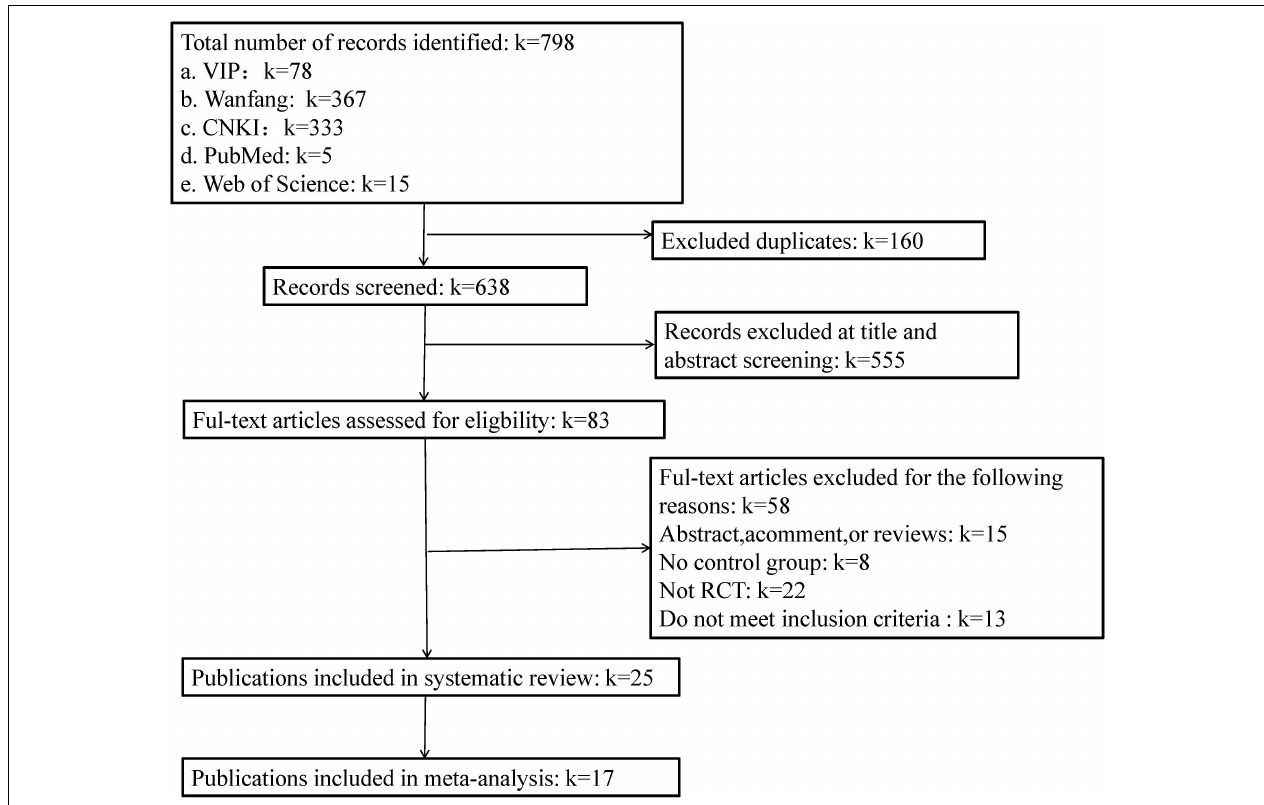
FIGURE 1 | A flowchart of the literature search and study selection according to the PRISMA standard.